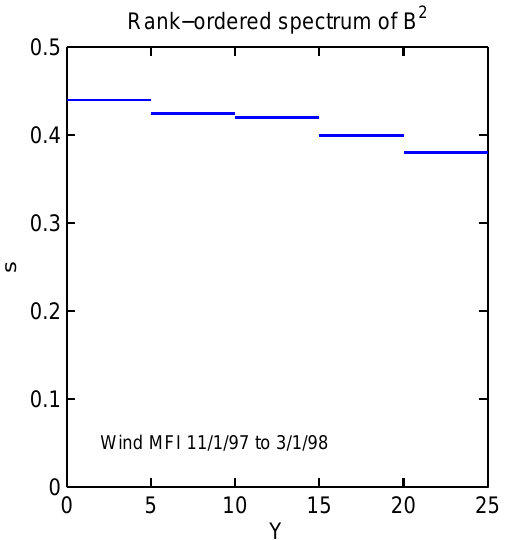
Fig. 4. Scaled PDFs for s = 0 . 44 for the solar wind data of Fig.